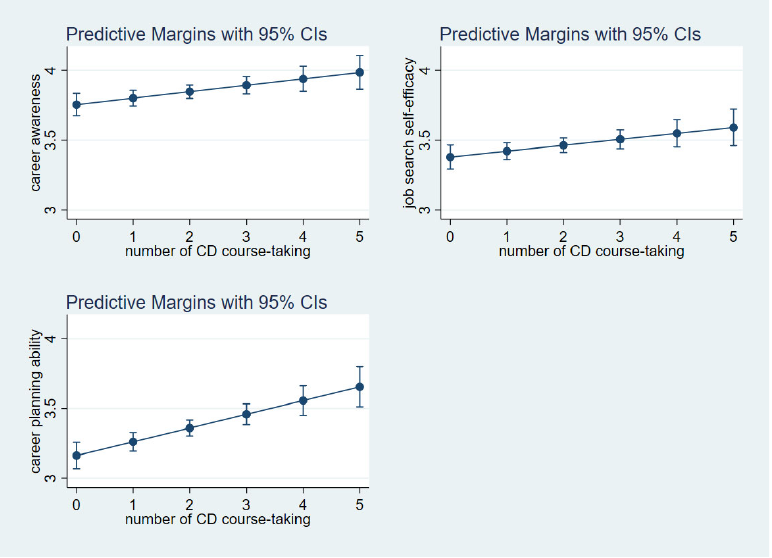
Figure 1. Predictive margins of career awareness, job search self ‐ efficacy, and career planning ability by the number of career development courses taken.